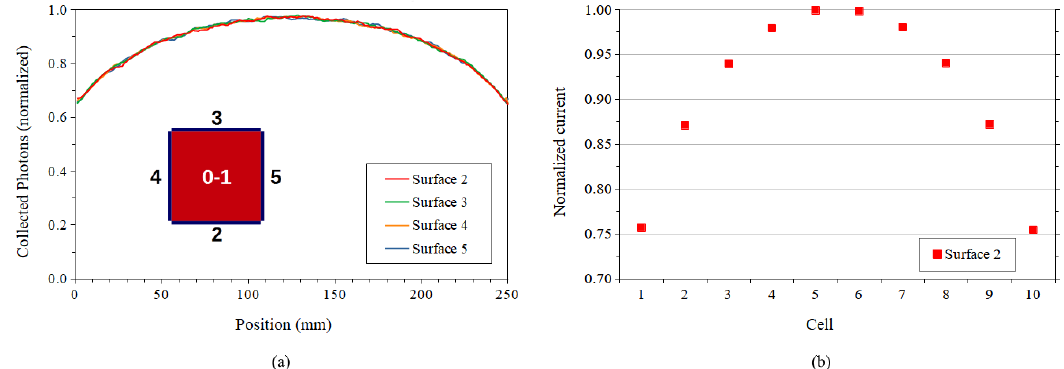
Figure 5. Unshaded LSC panel with four 10-cells PV arrays: ( a ) Normalized number of rays of light collected by the PV cells as a function of the position along the LSC side, which ranges from 0 mm to 250 mm. ( b ) Normalized current produced by each PV cell.